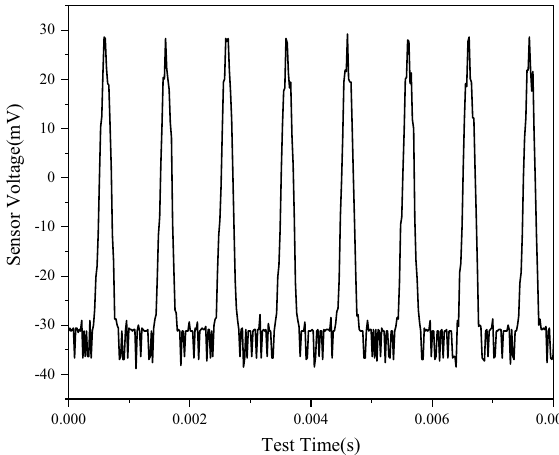
Figure 5. Sensing voltage variation during frozen soil measurement.